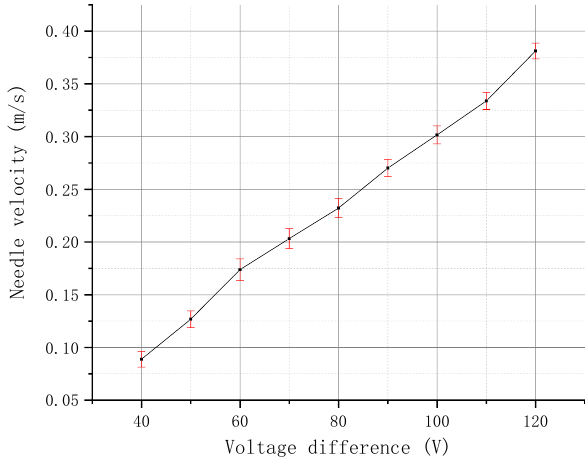
Figure 12. Relationship between needle velocity and voltage differences.